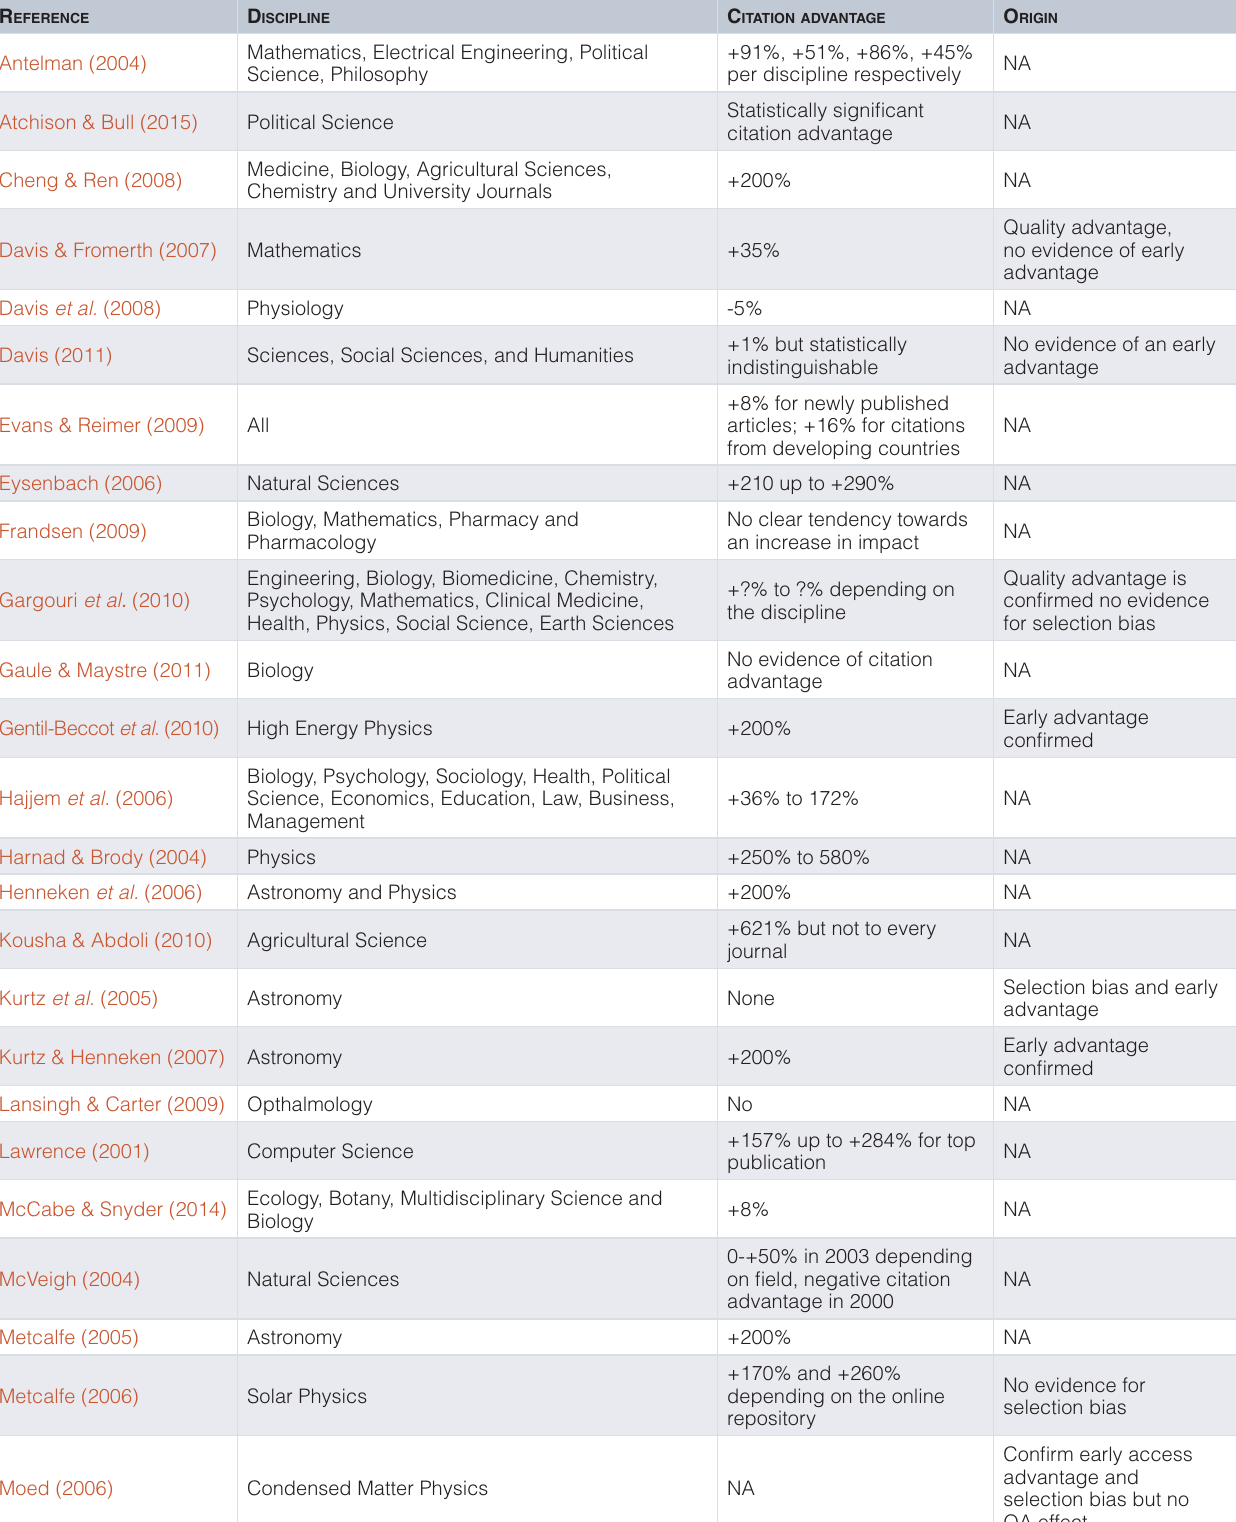
Table 2. Main scientific papers that have investigated and quantified the citation advantage as well as its origin. R